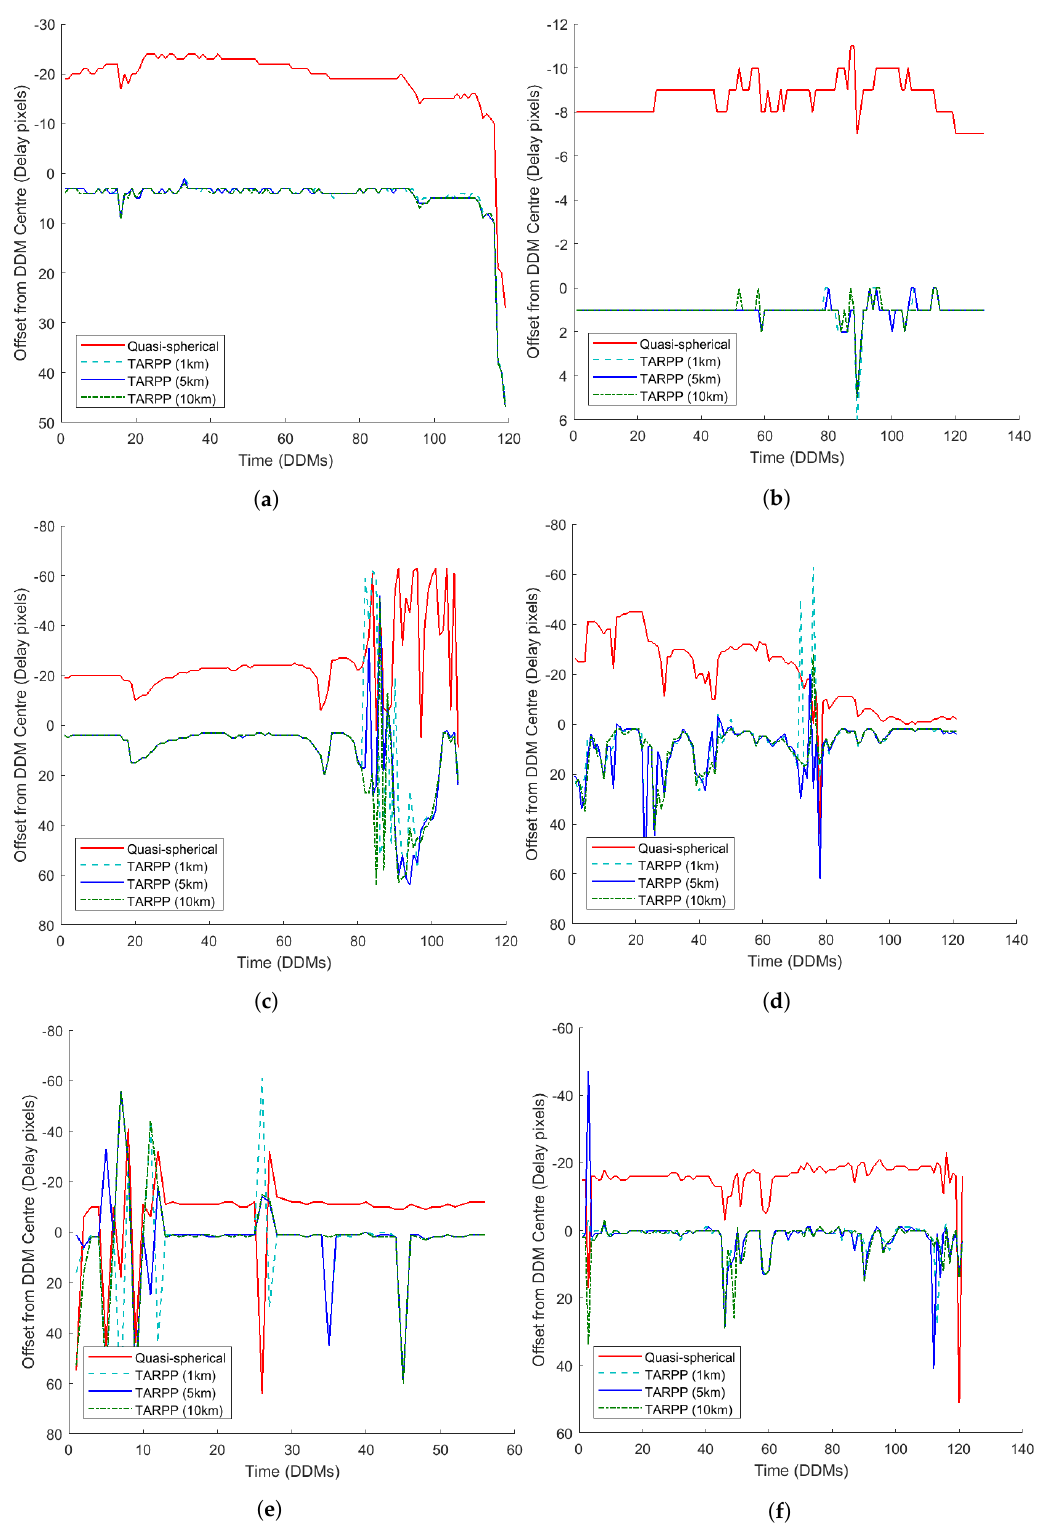
Figure 5. The results of Analysis 1a for an example PRN from each test dataset—plots of peak power offset from the centre of the DDM. ( a ) TT1, PRN 21; ( b ) TT2, PRN 15; ( c ) TT3, PRN 05; ( d ) TT4, PRN 20; ( e ) TT5, PRN 08; ( f ) TT6, PRN